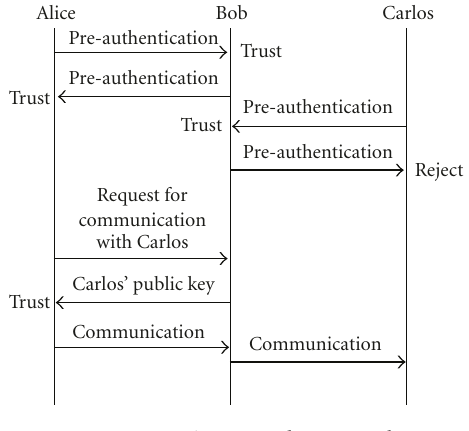
Figure 6: Devices procedure example.